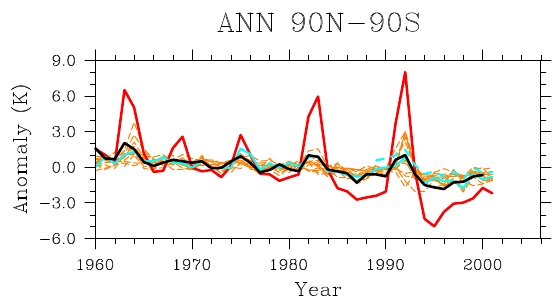
Fig. 10. Anomalies of annual mean global temperature at 50 hPa for ERA-40 (cyan solid line), ERA- Interim (dashed cyan line), CNRM-ACM (red line), CNRM-CCM (black line) and CCMVal-2 REF-B1 models(dashedorangelines). Anomaliesarethosew.r.t.the1980–1989period.